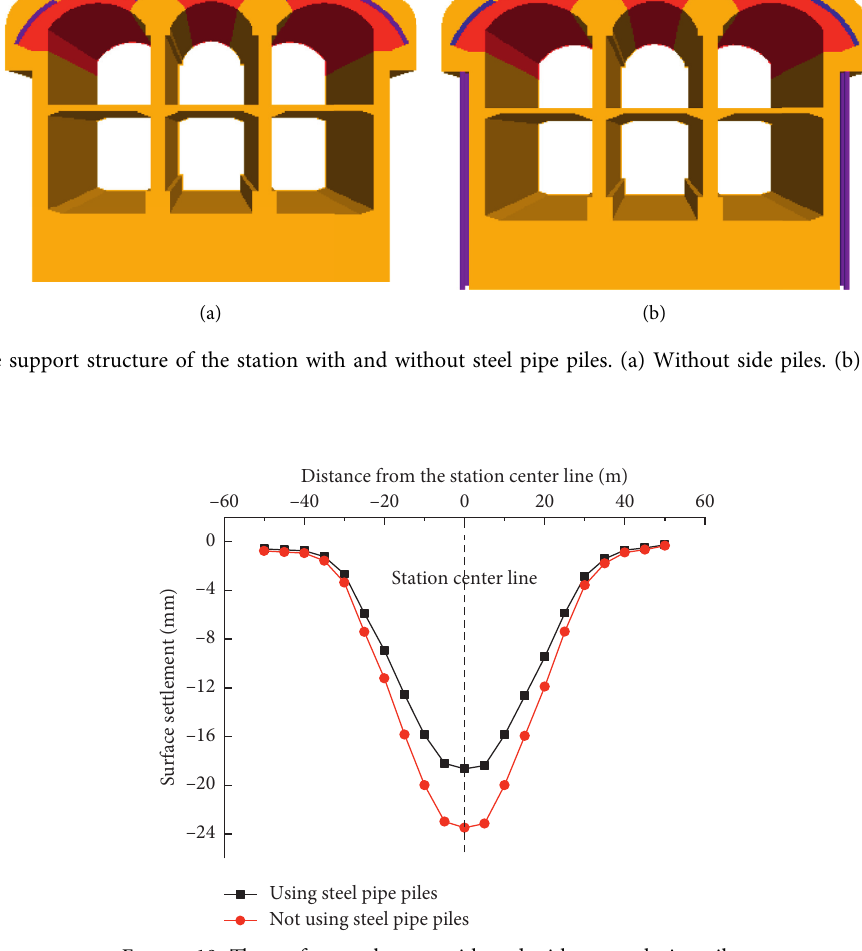
Figure 19: The surface settlement with and without steel pipe